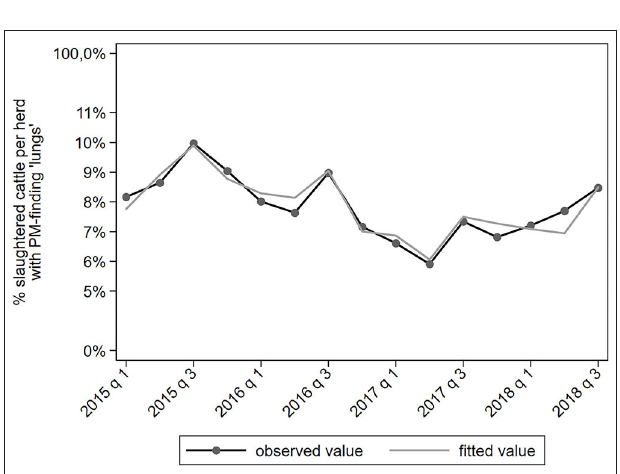
FIGURE 5 | Observed and predicted percentage of slaughtered cattle per dairy herd with a PM-finding categorized under “lungs,” per quarter between January 2015 to September 2018 ( N = 78,366).